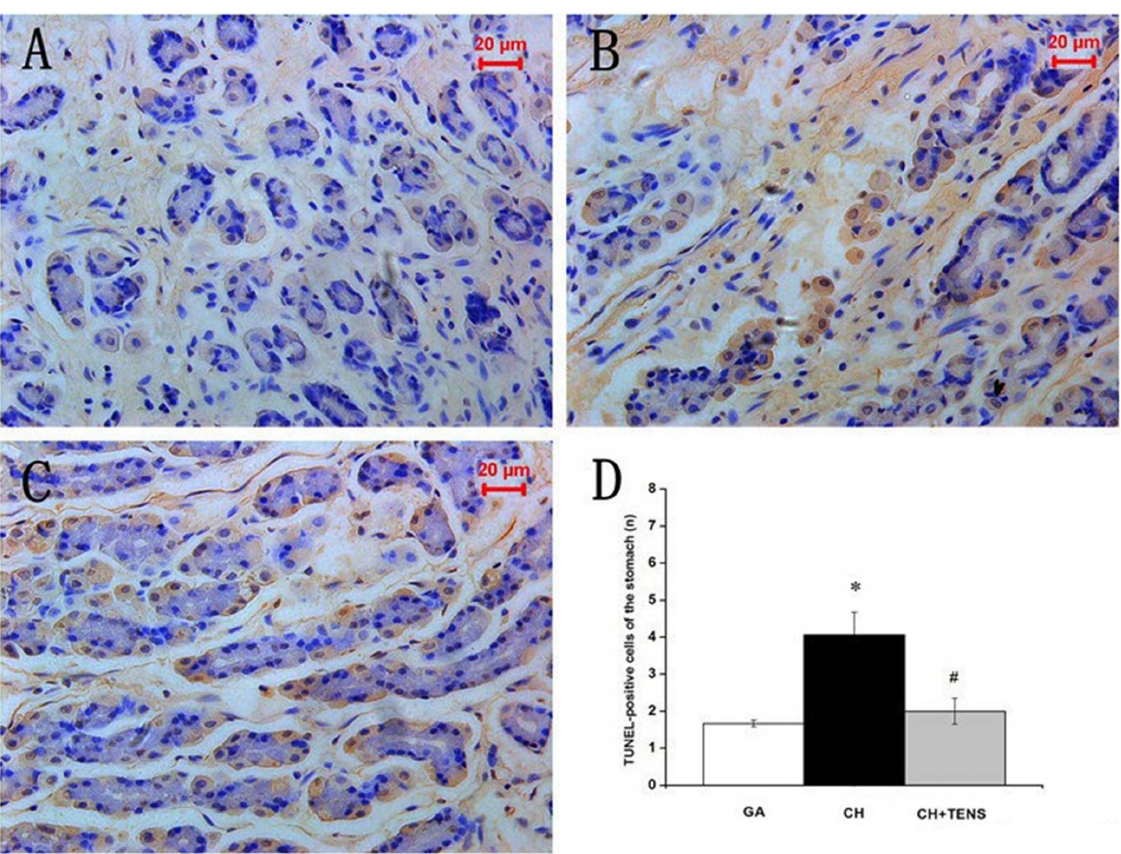
Figure 9. Terminal deoxynucleotidyl transferase-mediated dUTP-biotin nick end labeling (TUNEL) staining of canine gastric mucosa after controlled hypotension (CH). The number of TUNEL-positive cells was quantified at a high magnification ( 6 400). A significant increase in the number of TUNEL-positive cells was seen in the CH group (B) compared with the GA group (A). TENS significantly prevented the increase in TUNEL-positive cells in the TENS group (C) when compared with the GA group (D). The number of TUNEL-positive cells is presented as mean 6 standard error of the mean. * P , 0.05 vs. GA group, # P , 0.05 vs. CH group, n=6 per group. Scale bar =20 m m.